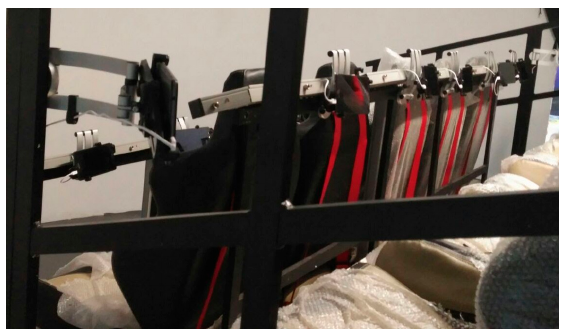
Figure 3. An image showing some of the air and water dispensers to the back of the first-row of seats, facing the audience located in the second row of seats. Individual tables are also depicted.